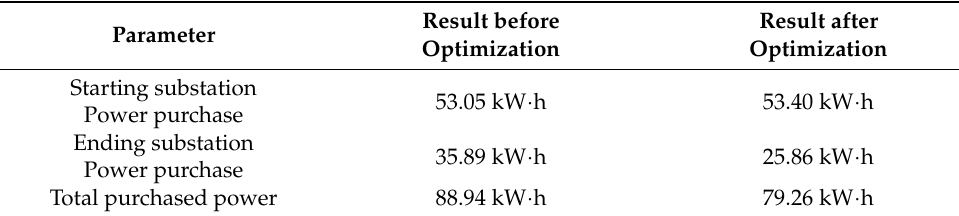
Figure 12. Fitness change trend. Table 5. Optimization